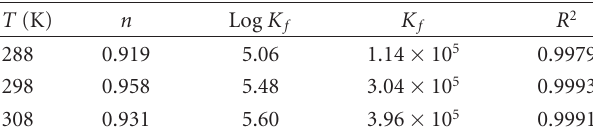
Table 2: Binding constants ( K f ) and number of binding sites ( n ) of the complex-DNA